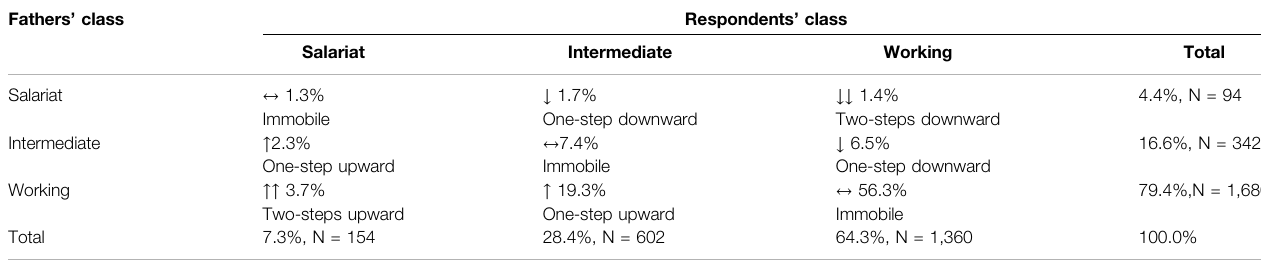
TABLE 1 | Intergenerational mobility trajectories in the analyses sample. Fathers ’